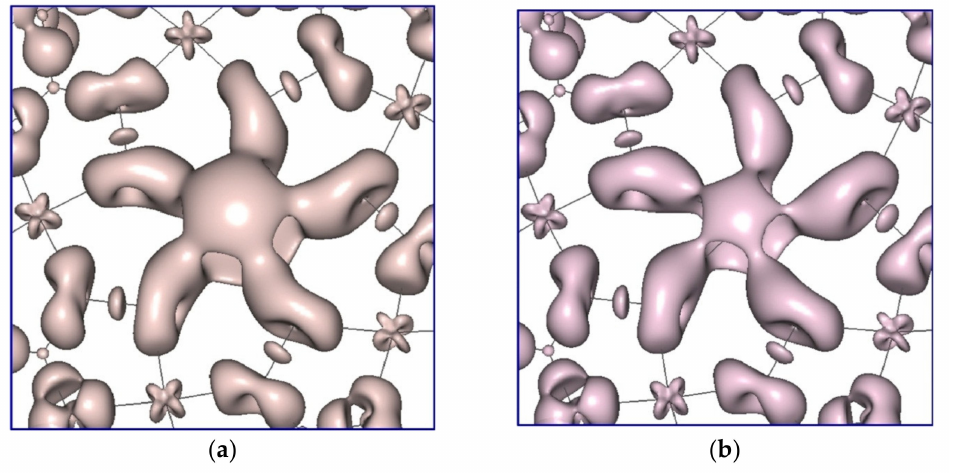
Figure 9. Deformation Electron Density isosurfaces at 0.01 a.u. in the region of the central ion and the five oxime oxygen atoms: ( a ) for [Bi(15-MC Cu(II)Tyrha -5)] 3 + ; ( b ) for [La(15-MC Cu(II)Tyrha -5)] 3 + . The isosurfaces are built at the same scale. The level of DFT calculations is PBE / x2c-TZVPall // SR-PBE /